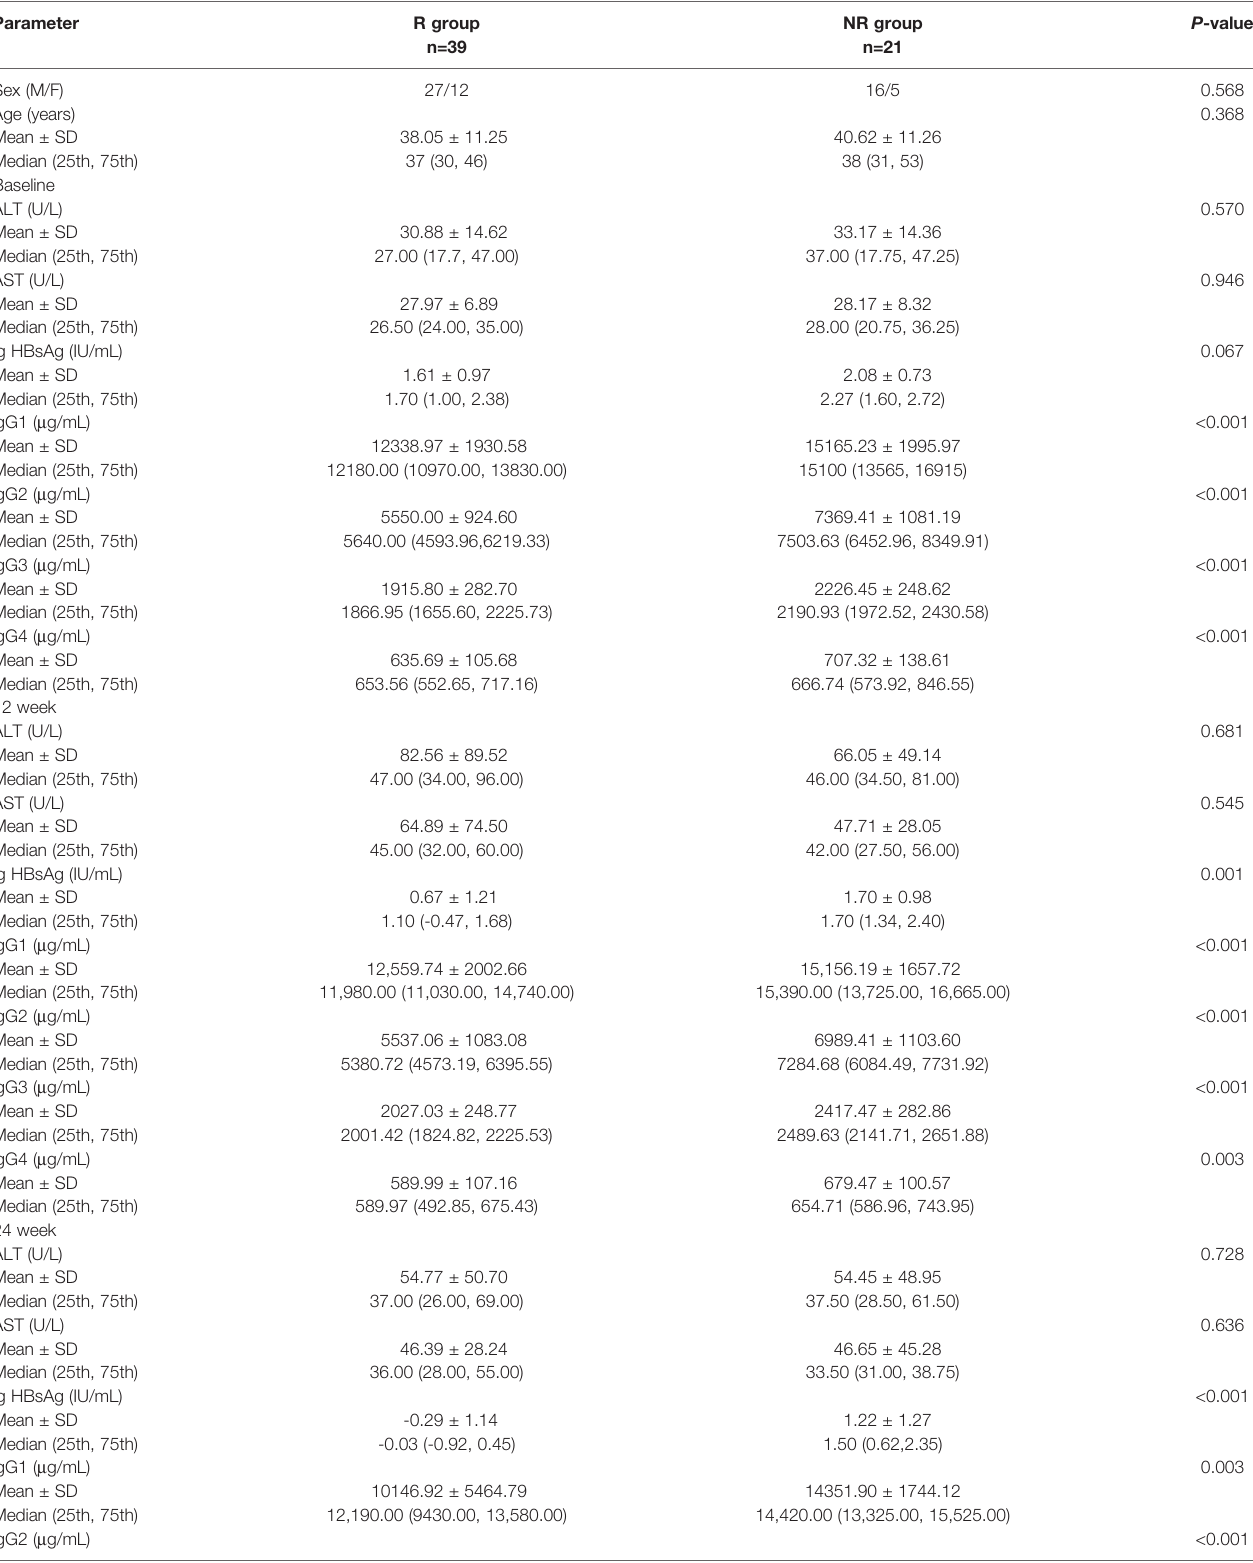
TABLE 1 | Characteristics of R and NR groups at baseline, and after 12 and 24 weeks of